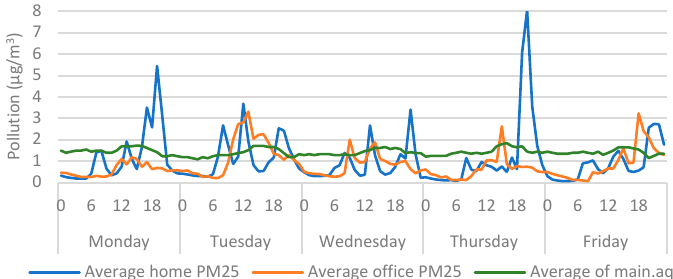
Figure 7. Average outdoor air pollution vs indoor particulates categorised by day > hour. Qualitative findings are displayed alongside the quantitative data for context.